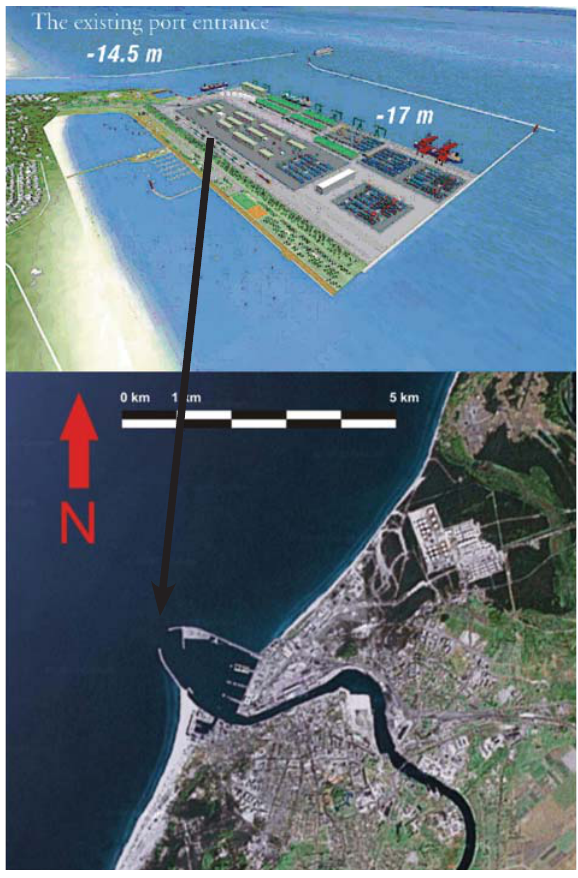
Fig. 5. Th e Port of Klaipėda + planned extension